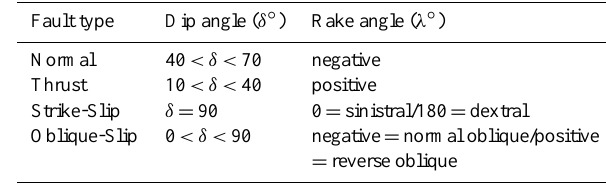
Table 3. Fault classification by focal